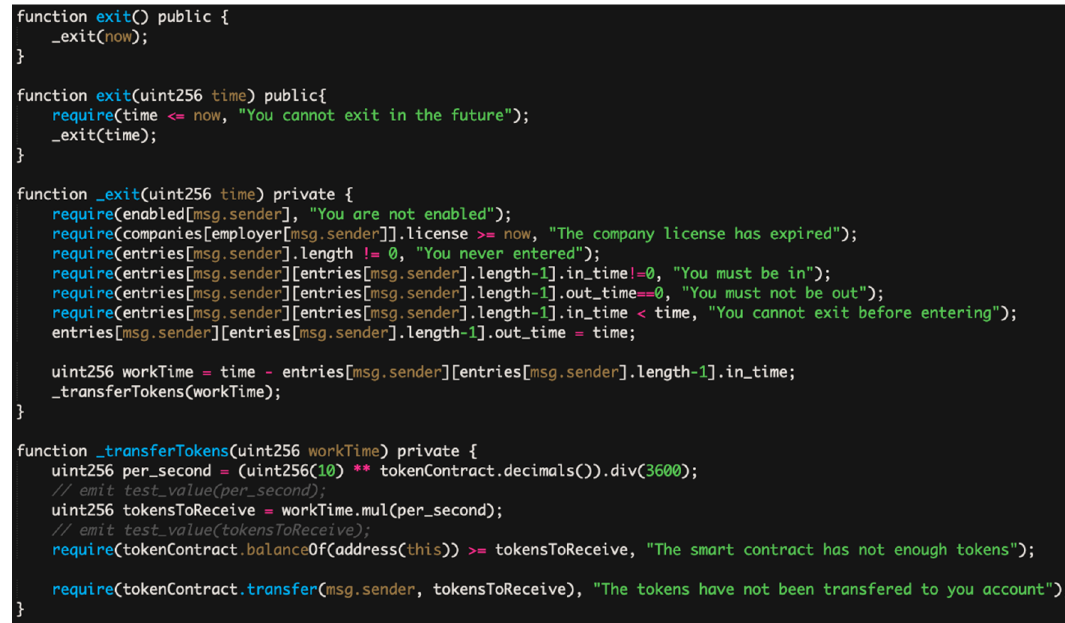
Figure 5. Smart contact methods for clocking out.